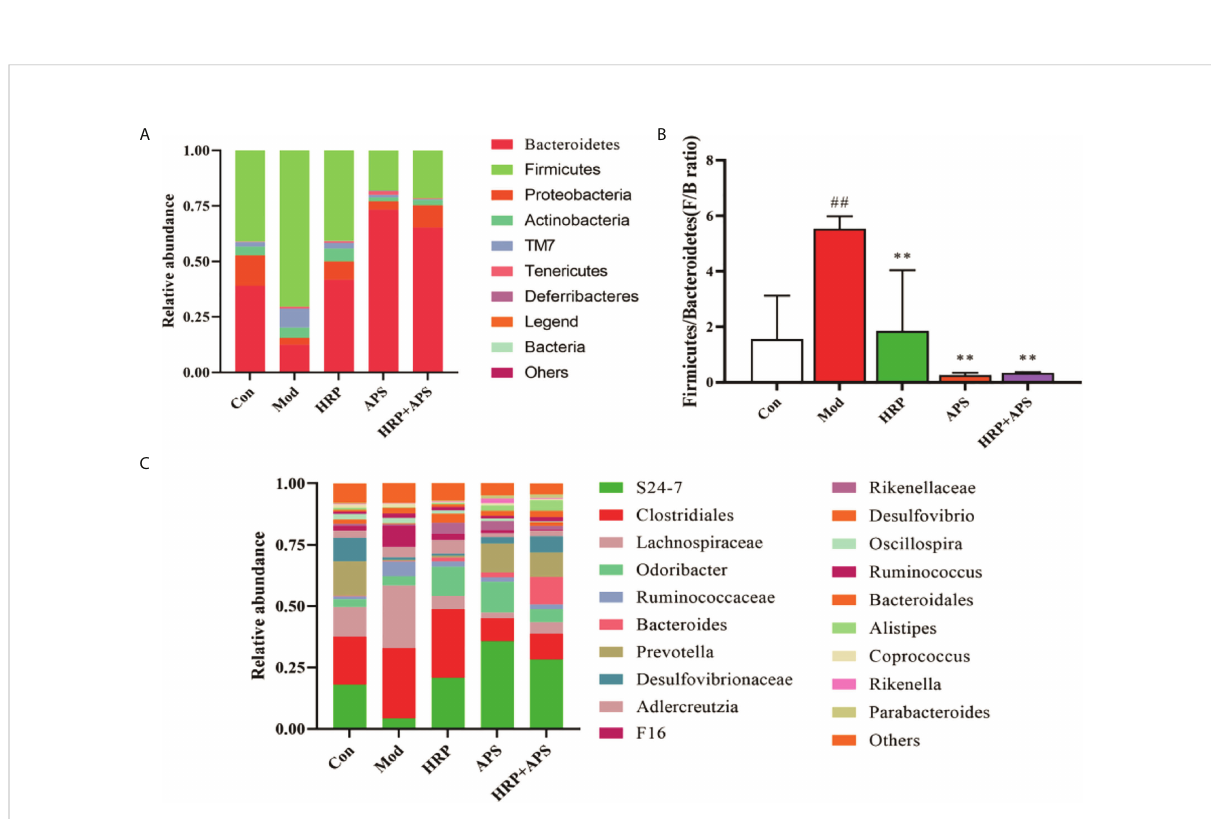
FIGURE 6 Effect of HRP, APS and the combination of HRP and APS on relative abundance of intestinal fl ora in AFLD mice. (A) Relative abundance at the phylum level. (B) Histogram of Firmicutes/Bacteroidetes ratio. (C) Relative abundance at the genus level. ## P < 0.01 vs. Con; **P < 0.01 vs. Mod.